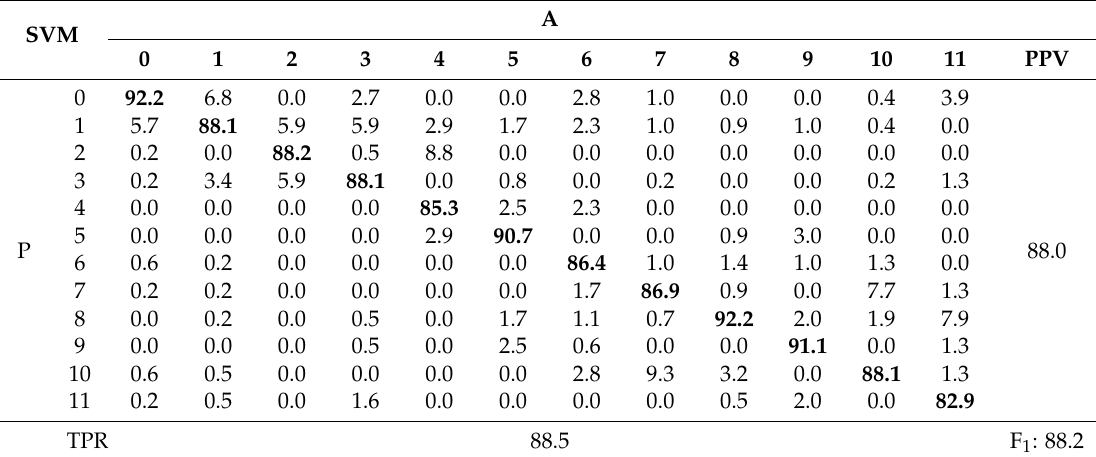
Table 8. The Confusion Matrix of the SVM Classifier.